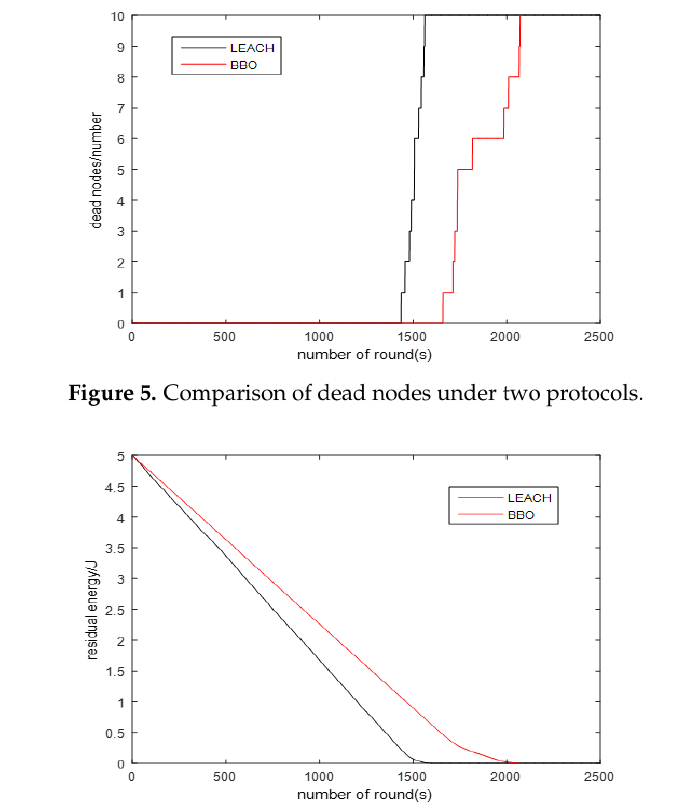
Figure 6. Comparison of residual energy under two